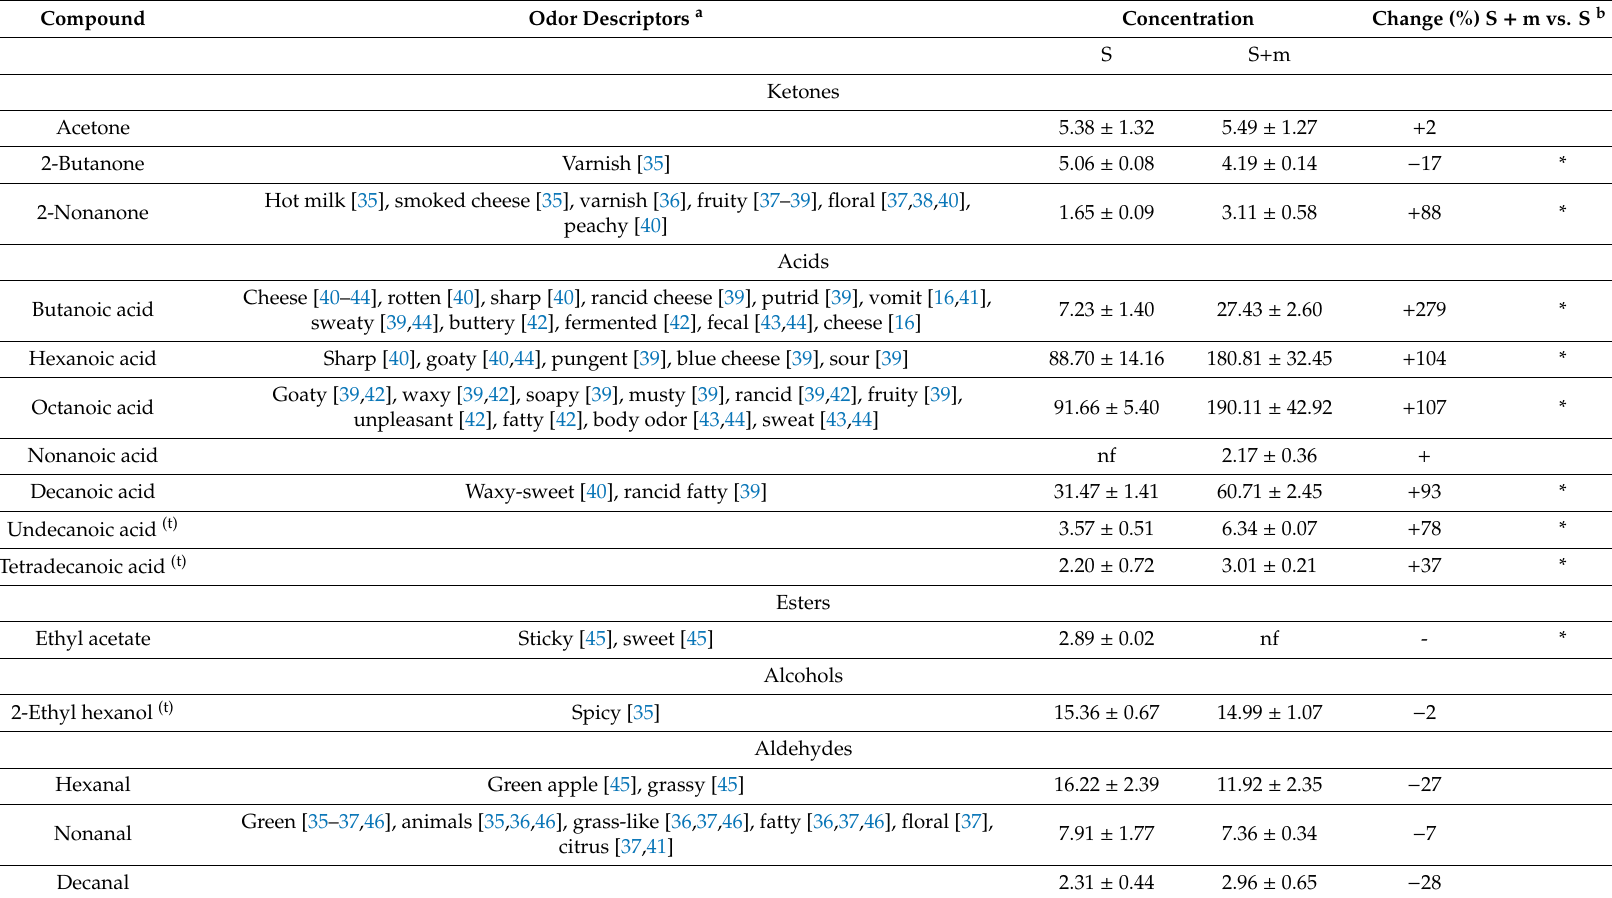
Table 4. Headspace concentrations ( µ g kg − 1 ) and odor descriptors of volatile compounds determined in milk samples obtained from cows fed nonmycorrhizal (S) and mycorrhizal (S + m) sorghum